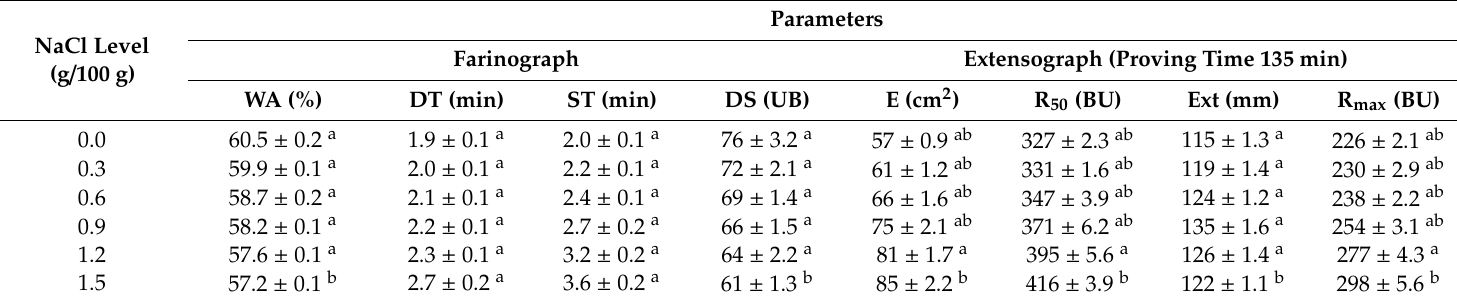
Table 4. Effects of different levels of sodium chloride addition on dough rheological properties during mixing.